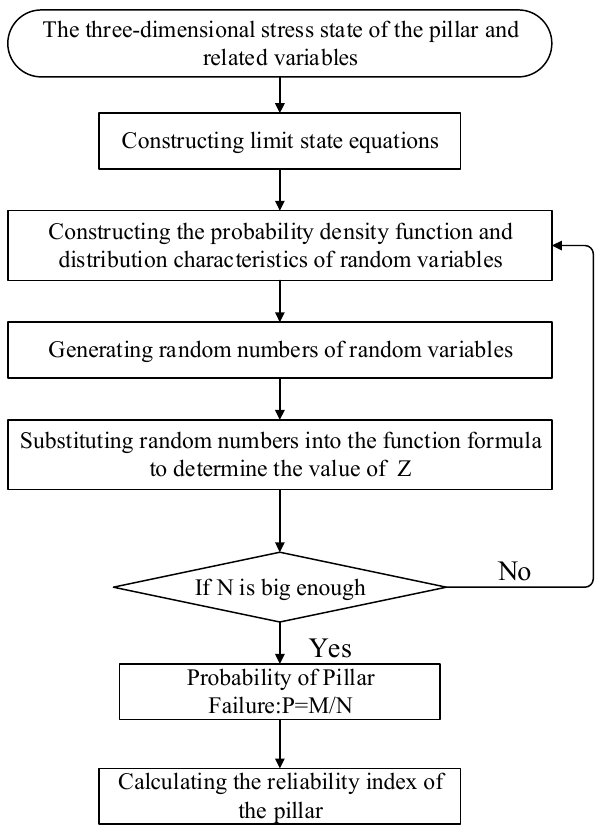
Figure 5. Pillar stability analysis based on reliability theory.